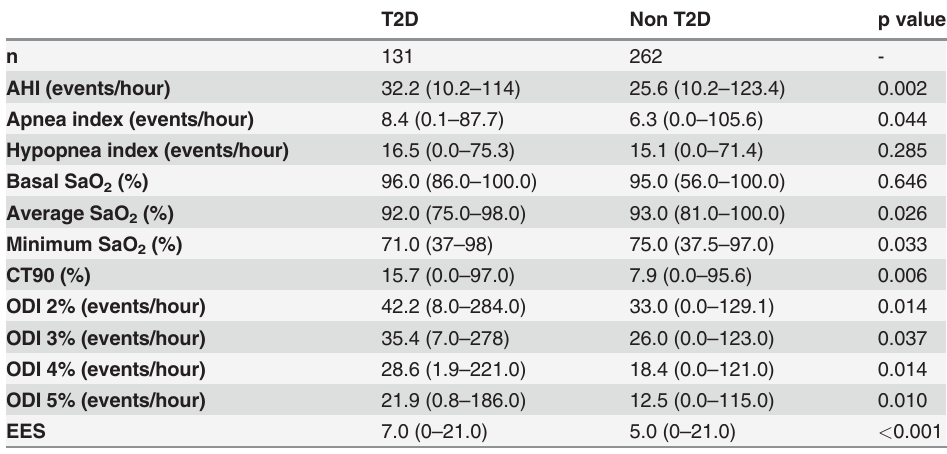
Table 2. Pulmonary parameters of participants included in the study according to the presence of type 2 diabetes.